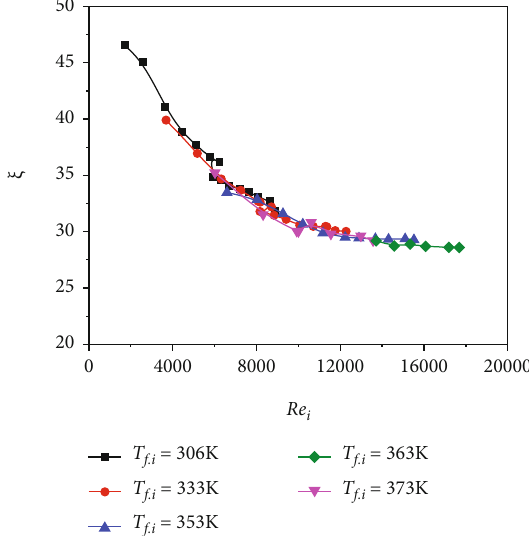
Figure 19: Variation of friction factor of main fuel